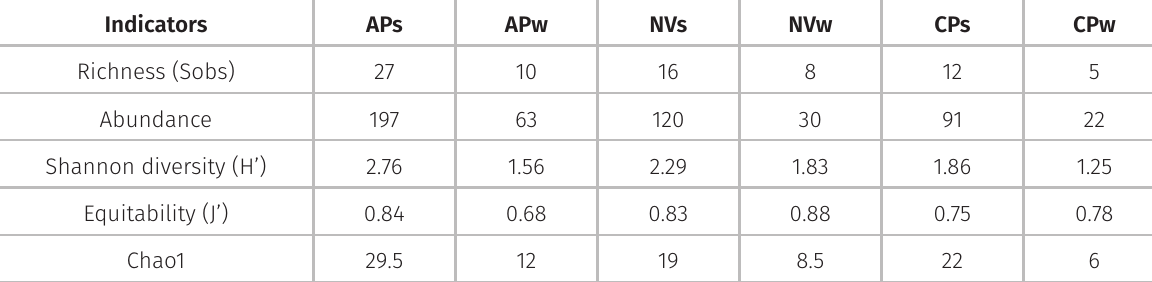
Table II. Richness, abundance, Shannon diversity index, equitability and Chao 1, from three environments in Colônia São Manoel, Pelotas, RS, Brazil (2017 –